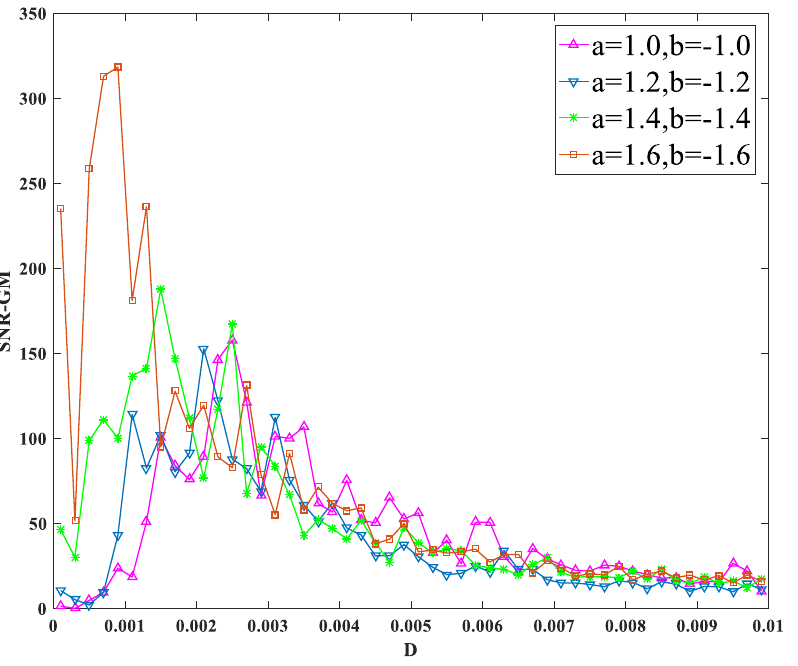
Figure 10. SNR-GM for different values of a and b .